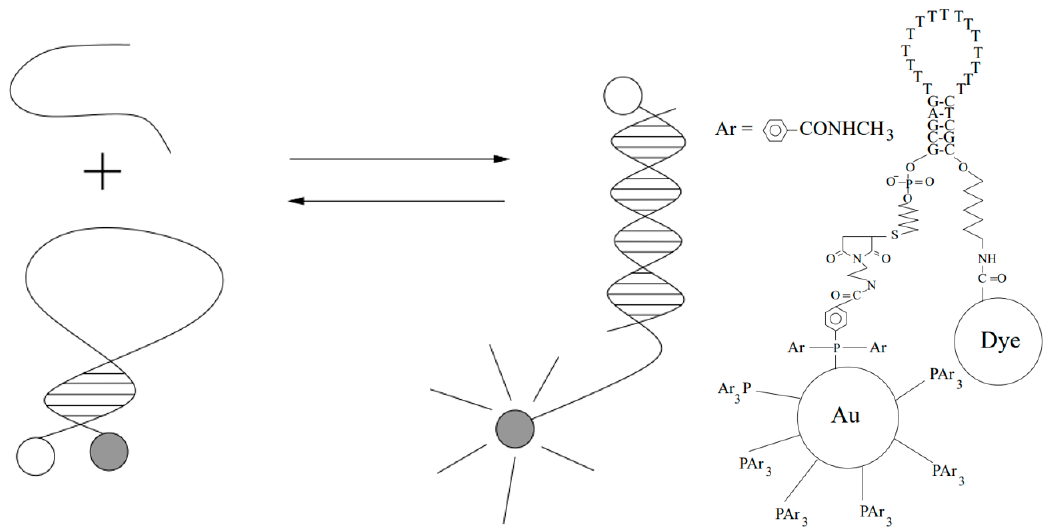
Figure 15. Two conformations of the gold-quenched molecular beacon and the dye–oligonucleotide– gold conjugate [10].